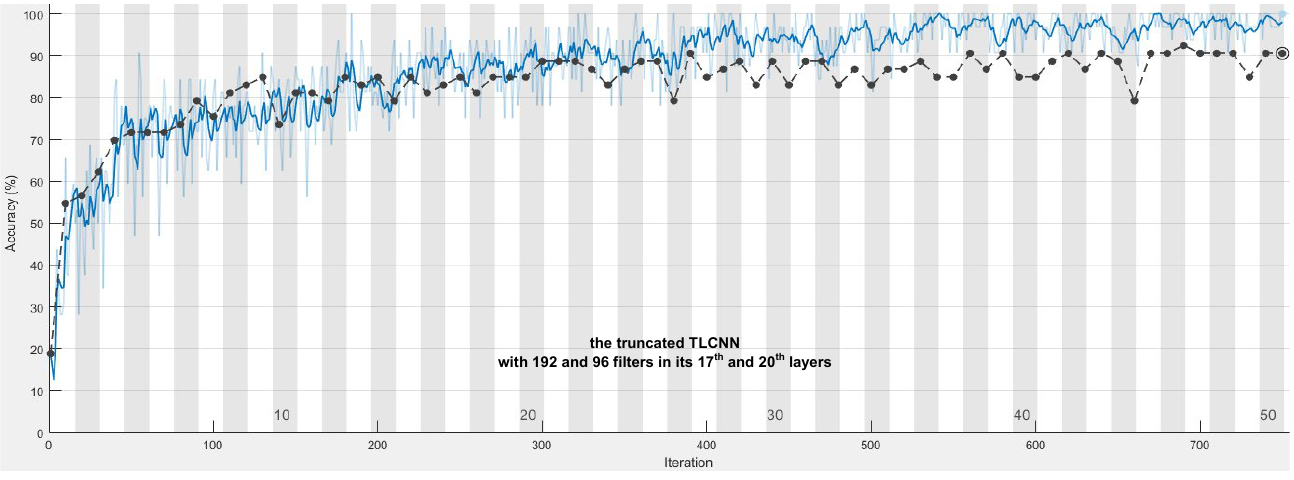
Fig. 14. The training progress of a TLCNN (15.1 MB) for the task by Fig. 11. The impact is 13.4, and the accuracy is greater than that of the AlexNet in Fig. 13.